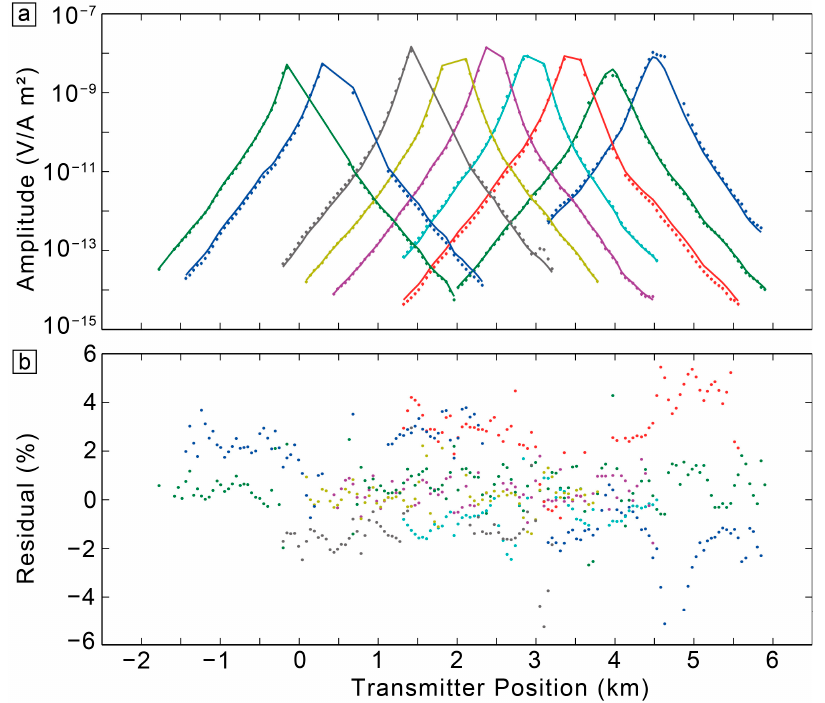
Figure 6. Fitting results and corresponding normalized residuals: ( a ) Fitting results of the 8 Hz Pmax electric field amplitude data (dots) and the model response curves (solid line); ( b ) Normalized residual distribution.